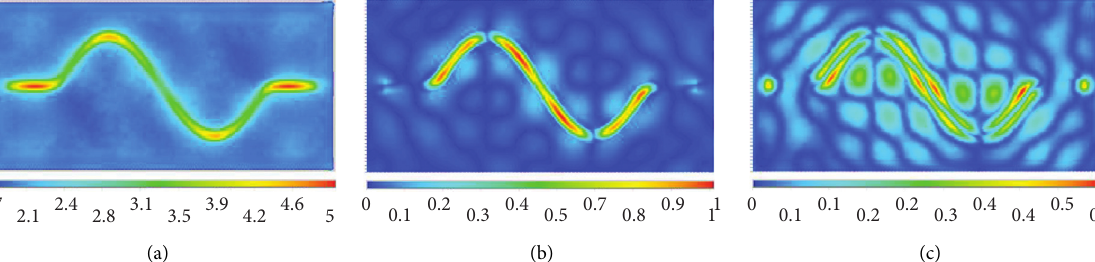
Figure 13: SV wave incident ( f � 1.5Hz, H � 100m, C